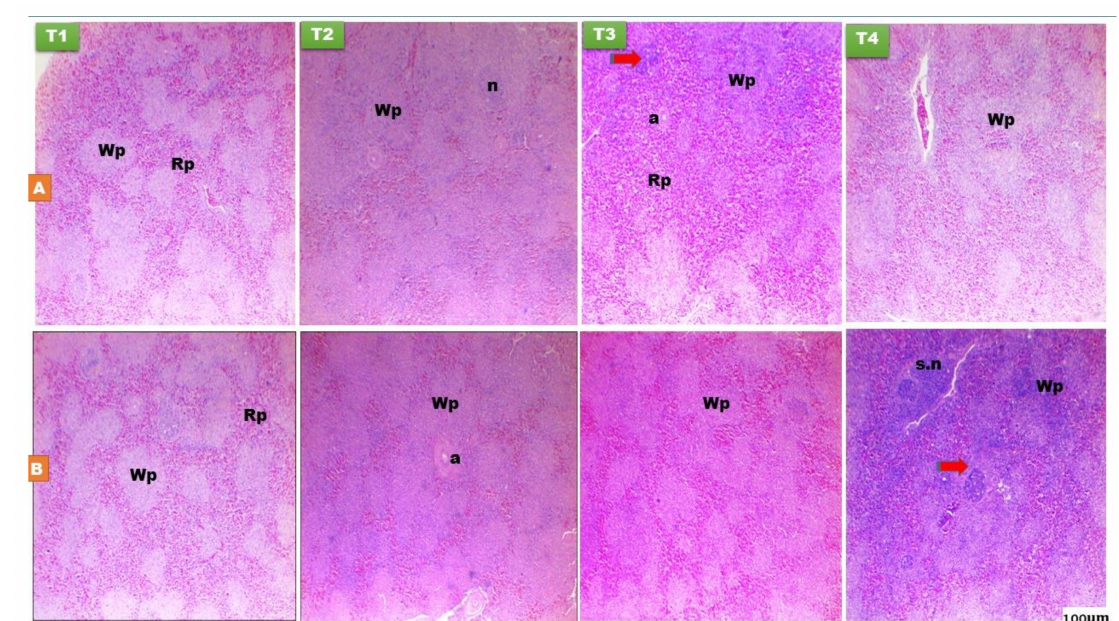
Figure 3. Histological structure of spleen at day 14 ( A ) and day 28 ( B ) of age of layer-type chicks exposed to fasting (control, T1) or early feeding on a layer starter diet (T2), a layer starter diet contained 3% molasses (T3), and a broiler starter diet (T4) during the first 72 h post-hatching. Histological examination showed variation in thickness of white pulp (Wp) and the red pulp (Rp), and germinal central area (red arrow). s.n, splenic nodules; n, nodule; a, central artery. (H and E ×